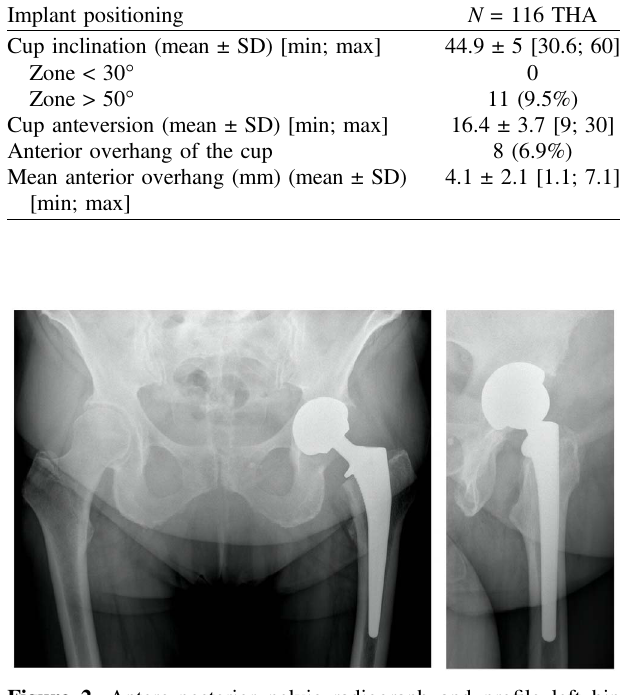
Figure 2. Antero-posterior pelvic radiograph and pro fi le left hip radiograph of a patient with psoas pain, despite a satisfying cup positioning without cup